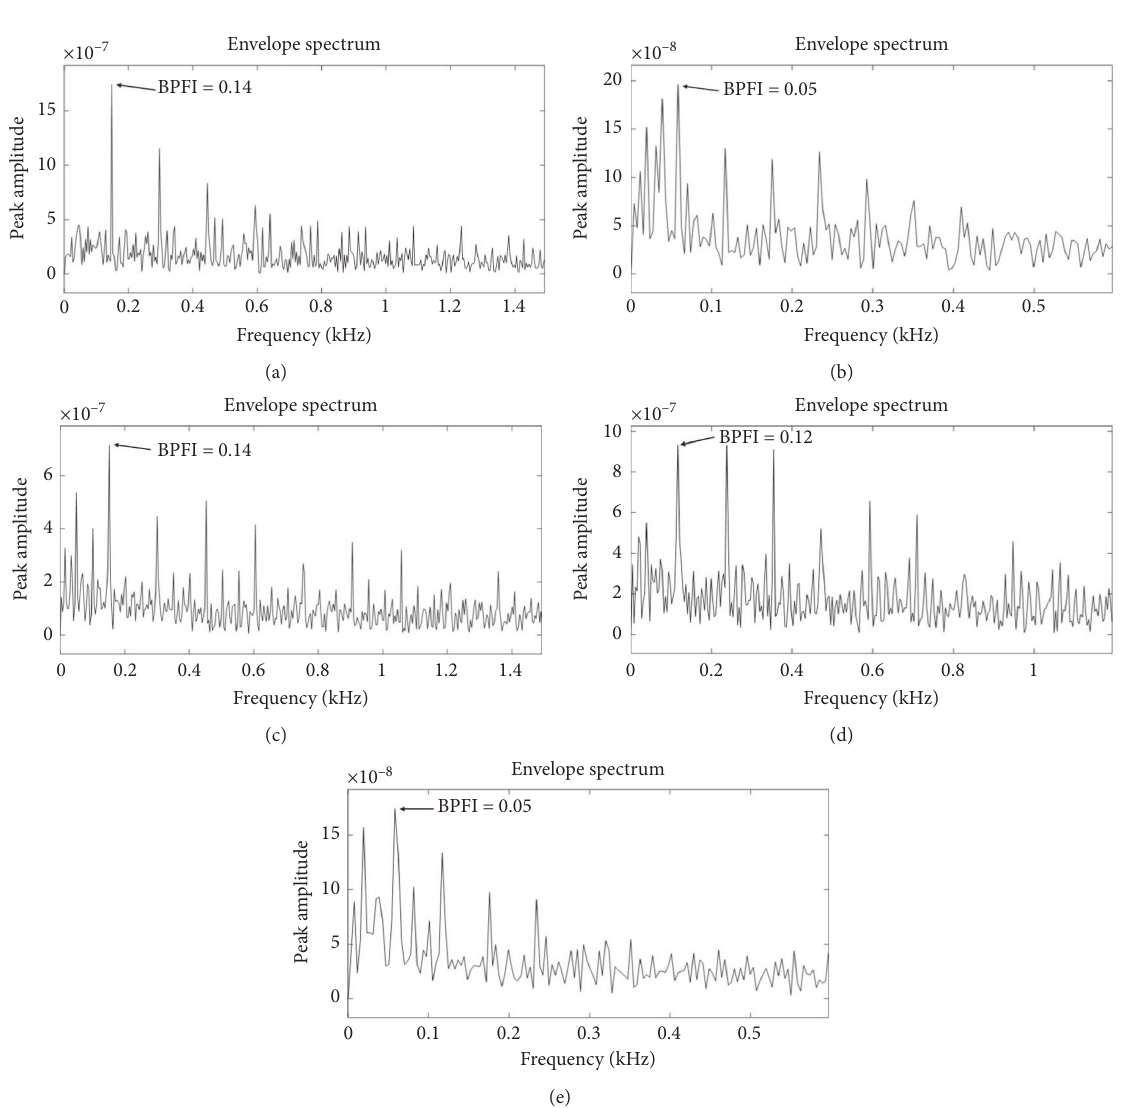
Figure 16: Envelope spectrum of signals after denoising. (a) Small defect, medium-high load, and 1500rpm. (b) Small defect, high load, and 600rpm. (c) Large defect, small load, and 1500rpm. (d) Large defect, medium-low load, and 1200rpm. (e) Large defect, high load, and